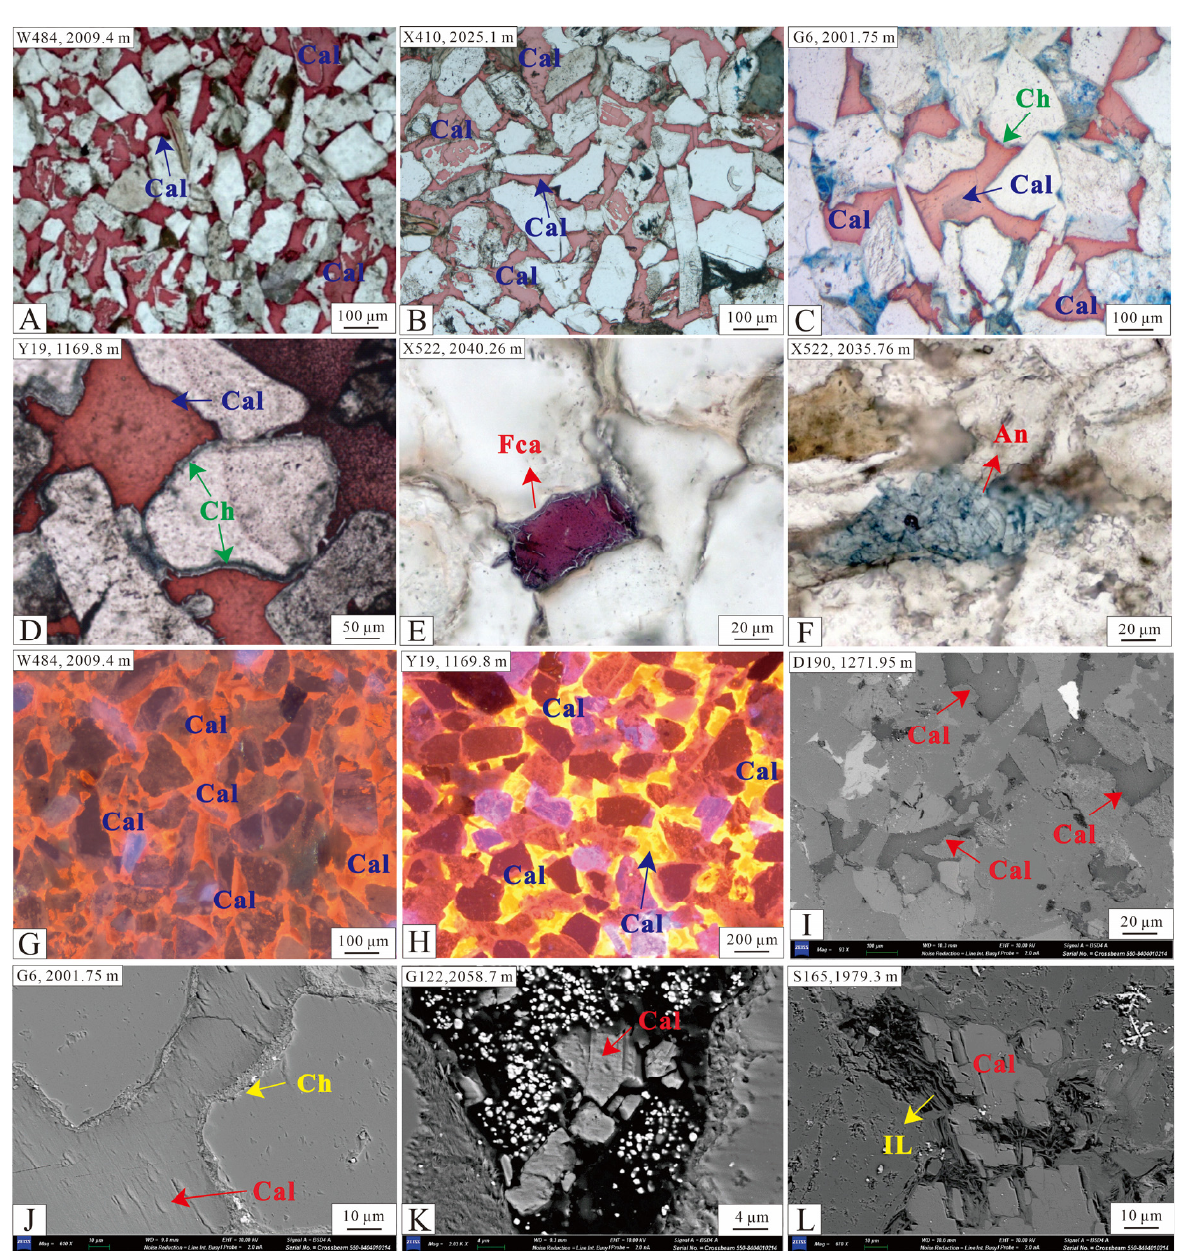
Figure 5. Types and characteristics of calcites of Chang 8 Member in the Yanchang Formation in study area. (A–D) Photomicrographs of thin sections under plane-polarized light suggesting calcites without chlorite coatings in the samples from W484 (2009.4 m) and X410 (2025.1 m) and calcites with the presence of chlorite coatings in the samples from G6 (2001.75 m) and Y19 (1169.8 m), respectively. (E,F) Photomicrographs of thin sections under plane-polarized light suggesting ferroan calcite and ankerite cements in the samples from X522 (2040.26 m) and X522 (2035.76 m), respectively. (G,H) CL photomicrographs suggesting type-I calcite cements have dark-orange luminescence color in the samples from W484 (2009.4 m) and type-II calcite cements have bright-yellow luminescence color in the samples from Y19 (1169.8 m), respectively. (I,J) SEM images suggesting calcites without chlorite coatings in the samples from D190 (1271.95 m) and calcites with the presence of chlorite coatings in the samples from G6 (2001.75 m). (K,L) SEM images suggesting calcites fill intergranular pores in the samples from G122 (2058.7 m) and S165 (1979.3 m), respectively. (Cal = calcite cements; Ch = chlorite; IL = illite).